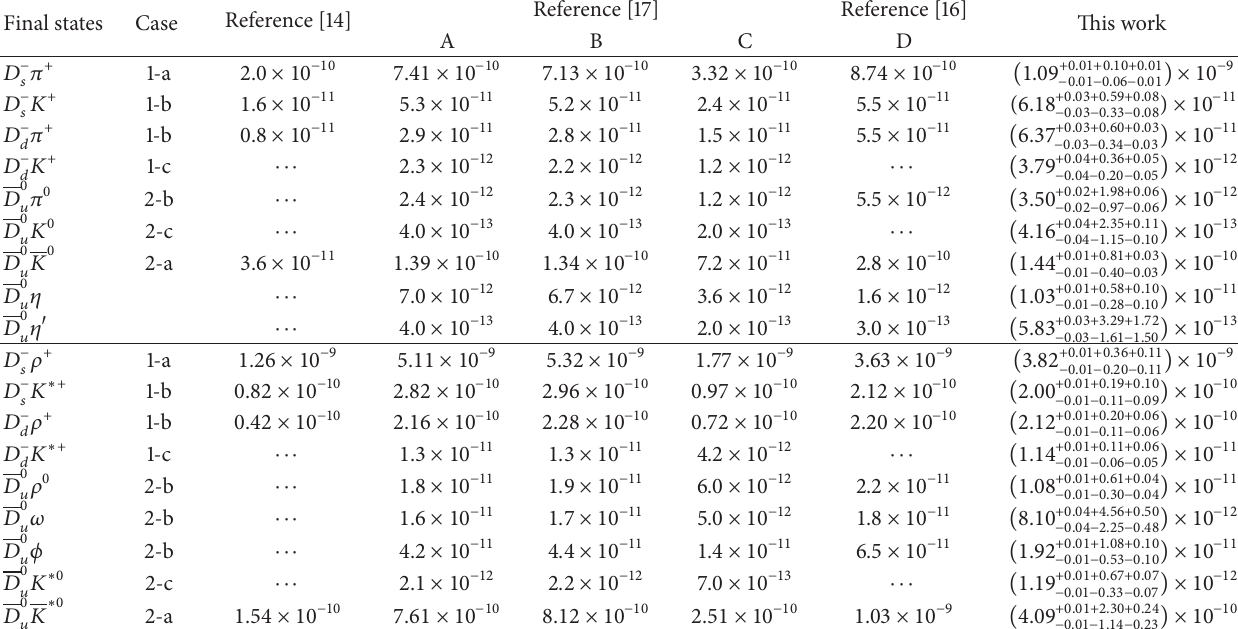
Table 5: Branching ratios for the nonleptonic two-body 𝐽/𝜓(1𝑆) weak decays, where the uncertainties of this work come from the CKM parameters, the renormalization scale 𝜇 = (1 ± 0.2)𝑚 𝑐 , and hadronic parameters including decay constants and Gegenbauer moments, respectively. The results of [14, 16, 17] are calculated with 𝑎 1 = 1.26 and 𝑎 2 = −0.51 . The results of [14] are based on QCD sum rules. The numbers in columns of “A,” “B,” “C,” and “D” are based on the WSB model with flavor dependent 𝜔 , QCD inspired 𝜔 = 𝛼 𝑠 𝑚 , and universal 𝜔 = 0.4 GeV and 0.5 GeV, respectively.